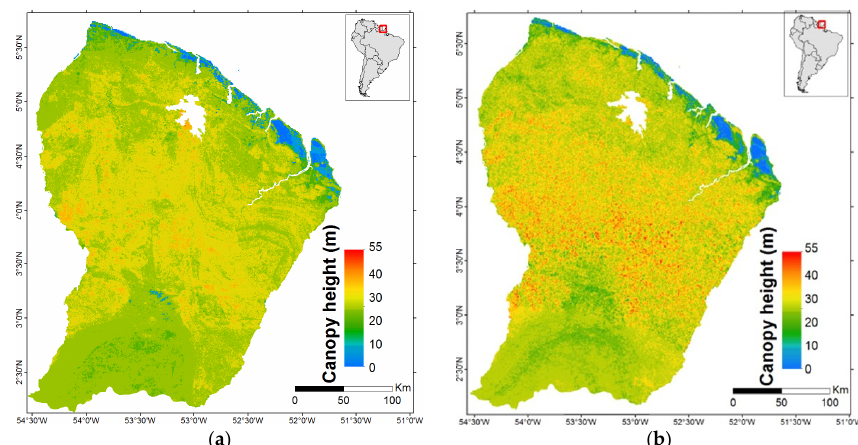
Figure 5. Wall-to-wall map of French Guiana with regression-kriging using as reference data canopy height estimates from: ( a ) GLAS dataset; and ( b ) LD dataset.